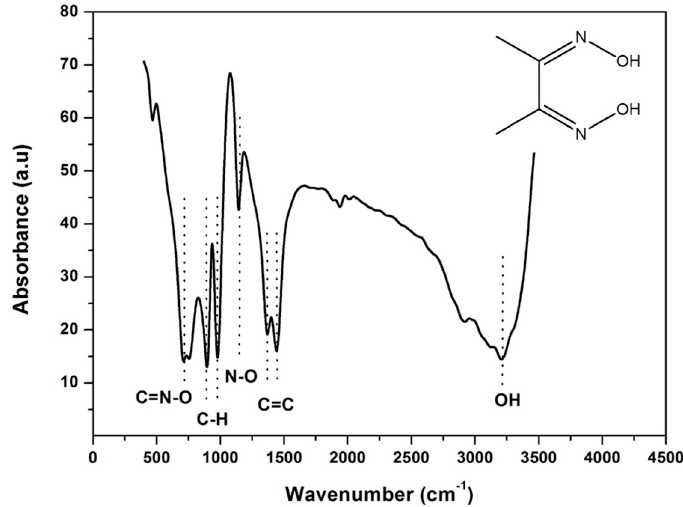
Figure 1. Fourier transform infrared spectrometry of dimethylglyoxime as a KBr pellet. Inset: schematic representation of the dimethylglyoxime structure.